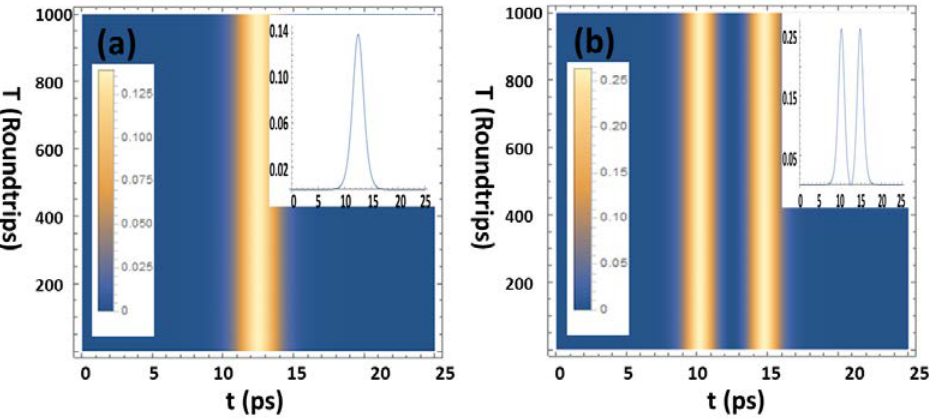
Figure 4. Numerical simulation results for ( a ) single-soliton case at g 0 = 2.5; ( b ) bound-soliton case at g 0 = 5, both within 1000 roundtrips propagation.